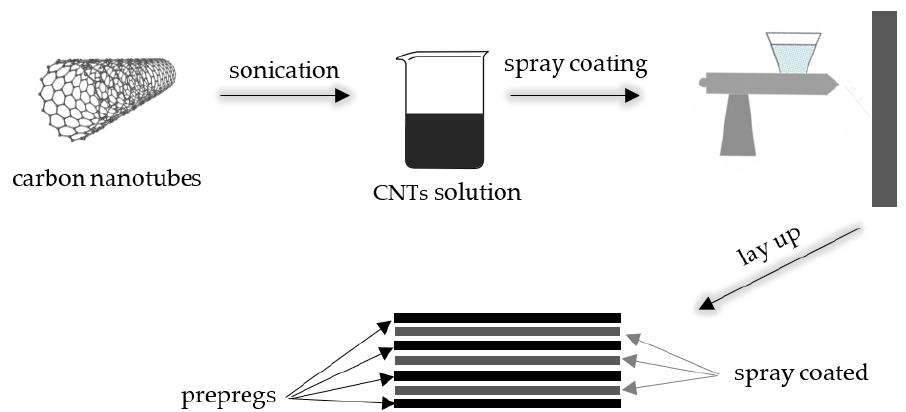
Figure 3. Schematic of composite fabrication with additional conductive layer formed by spray application of filler solution (source: own work on the basis of [57]).